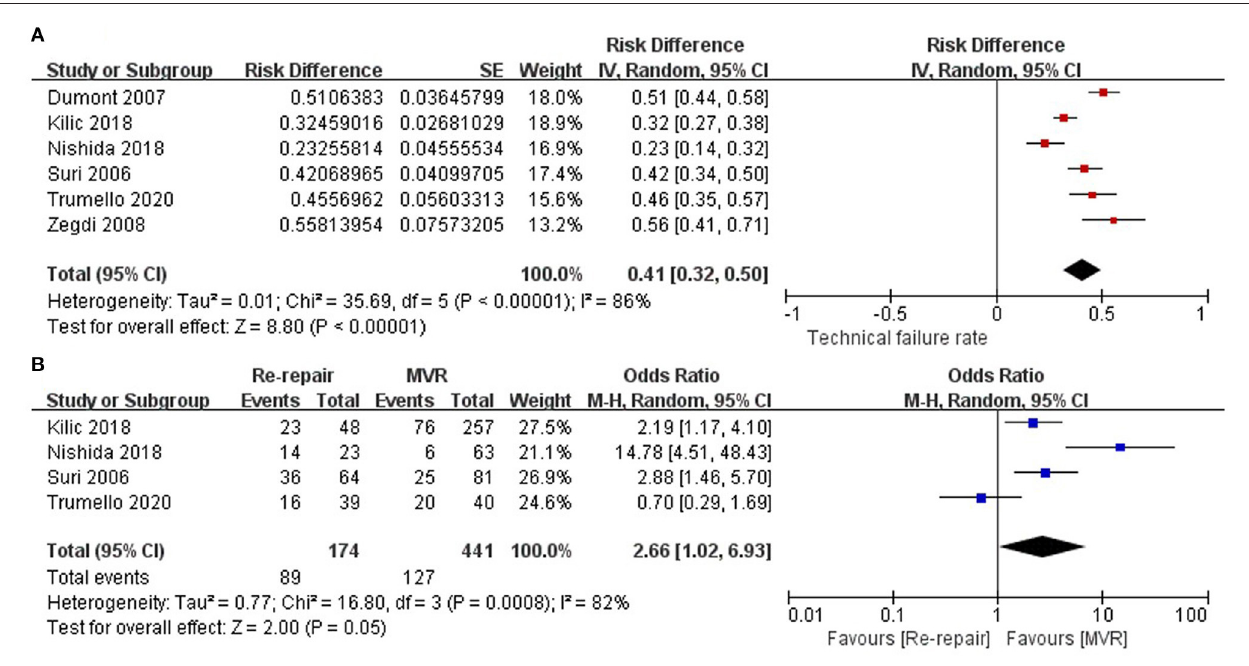
FIGURE 2 | Mode of mitral valve repair failure. (A) Incidence of technical failure of the entire cohort; (B) incidence of technical failure in the re-repair and MVR groups. SE, standard error; IV, inverse variance; CI, confidence interval; M-H, Mantel-Haenszel; MVR, mitral valve replacement.